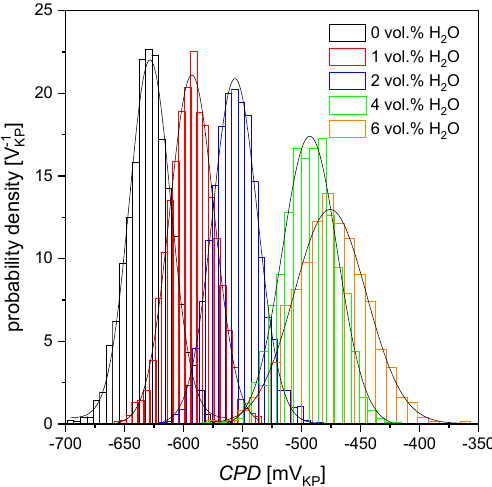
Figure 6. Histograms of contact potential difference ( CPD ) determined using maps shown in Figure 5; solid lines—fit of the Gaussian distribution (see Equation (7)); V KP is the voltage measured versus Kelvin probe.